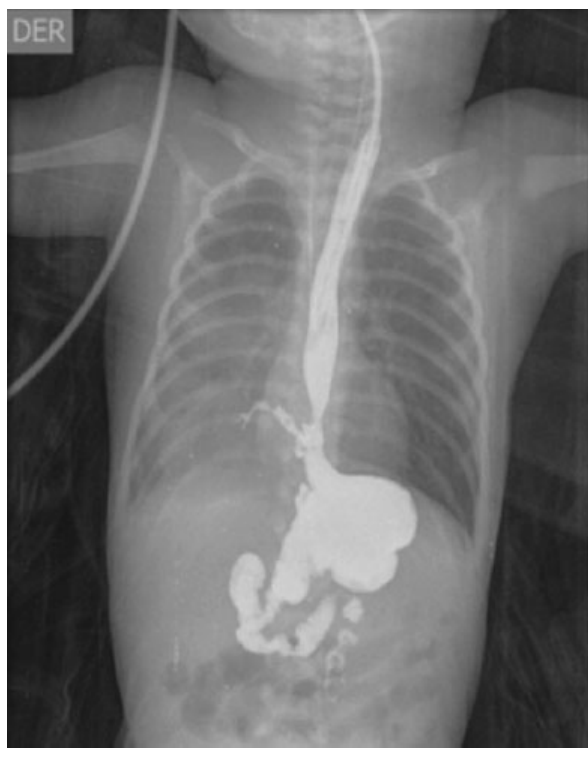
Fig. 2 Upper digestive tract X-rays: Partial obstruction of the distal esophagus with right bronchial tree image stemming from the site of the obstruction.